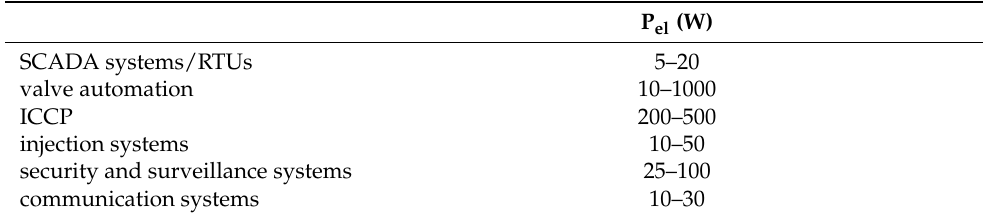
Table 1. Average power requirements of electric powered applications in the gas transmis- sion/distribution